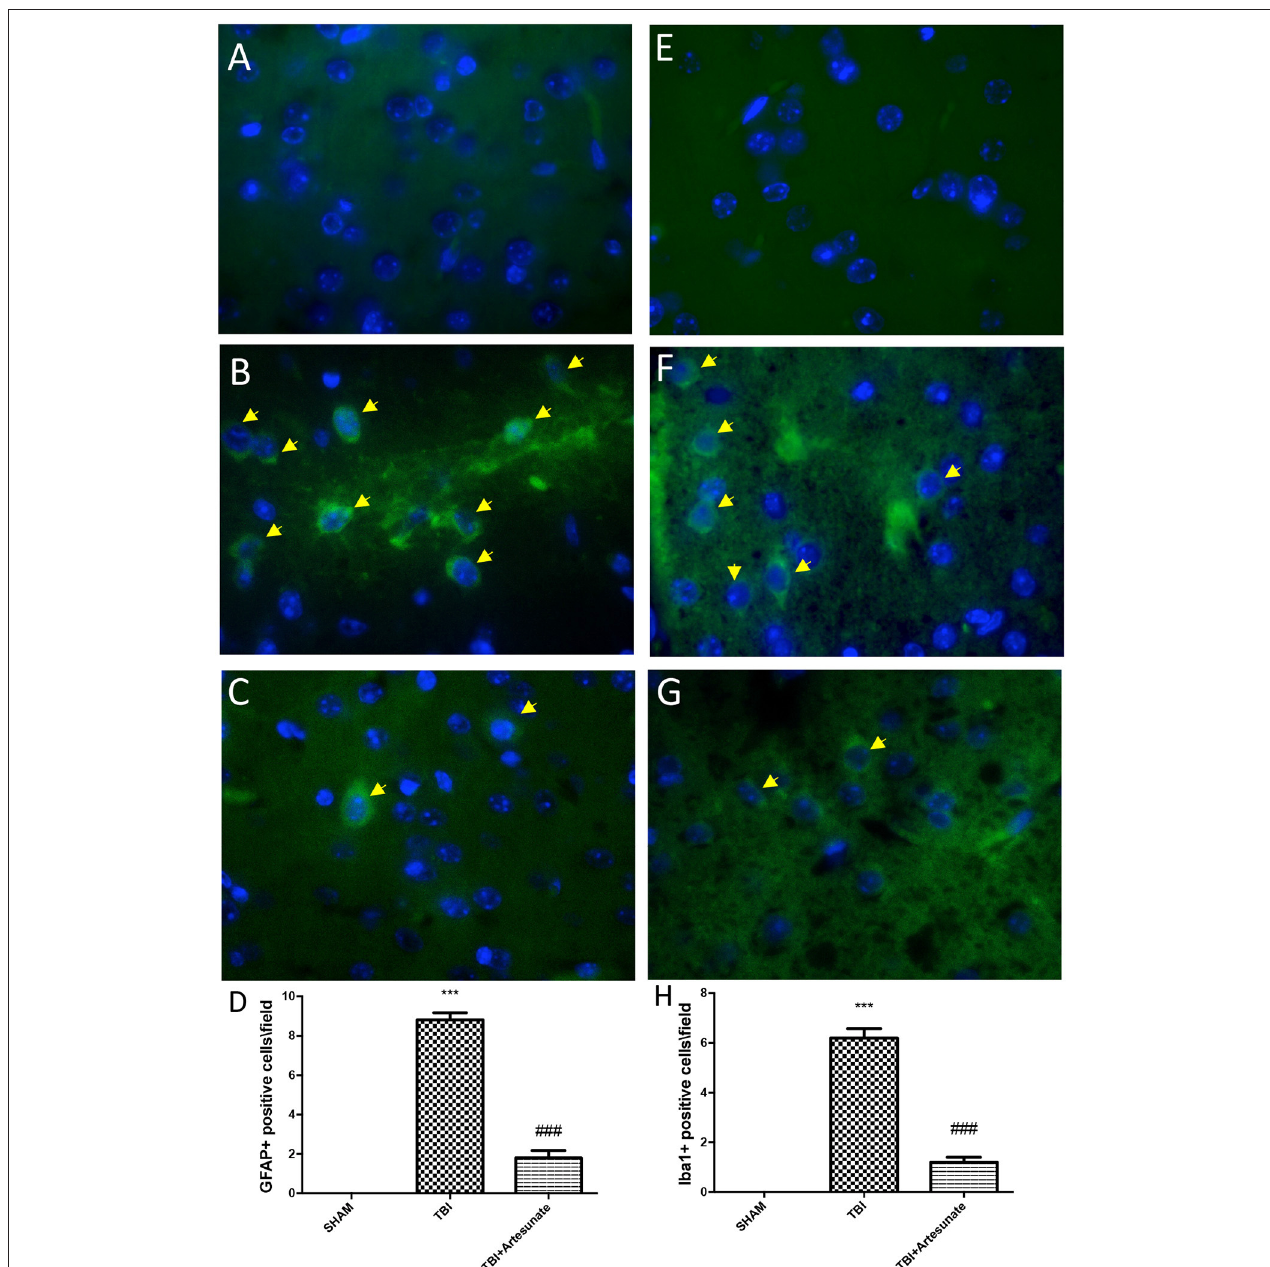
FIGURE 6 | Protective effect of artesunate treatment on astrocytes and microglia activation. (A,E) Showed no immunoreactivity for GFAP and Iba-1 respectively in sham brain tissue. Twenty-four hours after TBI injury in brain tissue there is a significant increase in positive cells for GFAP and Iba-1 as show in (B,F) respectively, see yellow arrows. When compared with TBI group treatment with artesunate significantly reduce the number of positive cell for GFAP and Iba-1as show in figure (C,G) respectively, see yellow arrows. (D) GFAP densities measured, panels. (H) Iba-1 densities measured. Data are expressed as Mean ± SEM from N = 10 Mice for each group, *** P < 0.001 vs. corresponding sham group. ### P < 0.001 vs. corresponding TBI. ( F -value for GFAP = 231.6. df = 2. r 2 = 0.9747) ( F -value for IBA-1 = 180.2. df = 2. r 2 =